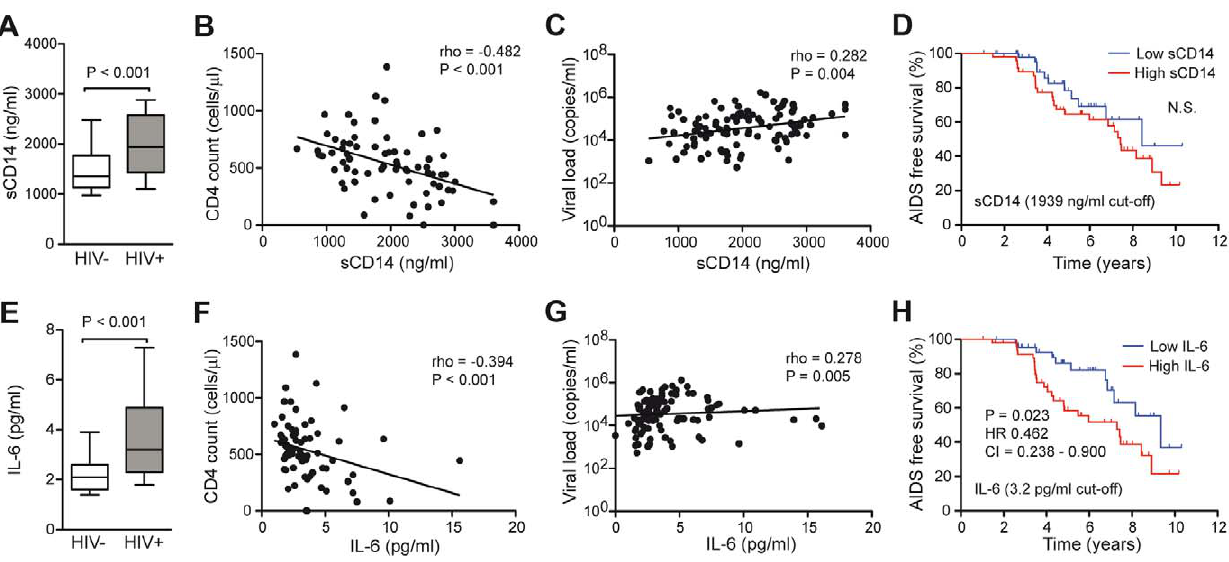
Figure 4. Associations between sCD14 and IL-6 levels in plasma and measures of HIV-1 disease progression. (A) Box and whisker plot showing sCD14 levels in plasma from HIV-1 infected (n=103) and HIV-1 uninfected (n=40) subjects. Spearman rank correlations between sCD14 in plasma and (B) CD4 absolute T cells counts, and (C) viral load. (D) Kaplan-Meier analysis comparing the time to AIDS. HIV-1 positive subjects with sCD14 levels above and below the median (1939 ng/ml) were not statistically different (Log-rank P=0.185, Hazard Ratio (HR) 0.631, 95% CI=0.319 to 1.247). (E) Box and whisker plot showing IL-6 levels in plasma from HIV-1 infected (n=103) and HIV-1 uninfected (n=40) subjects. Spearman rank correlations between IL-6 in plasma and (F) CD4 absolute T cells counts and (G) viral load. (H) Kaplan-Meier analysis comparing the time to AIDS. HIV-1